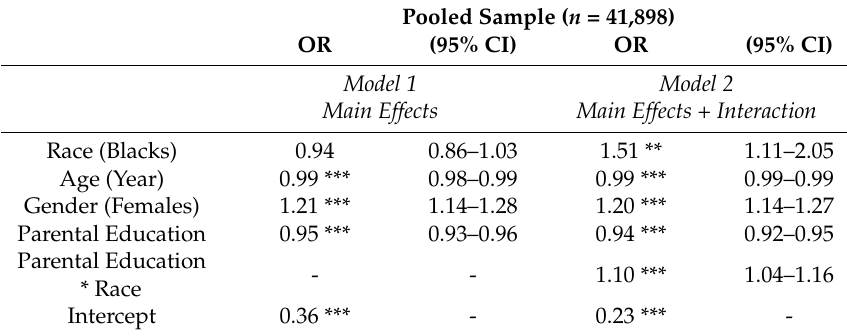
Table 3. Summary of linear regression models in the pooled sample.